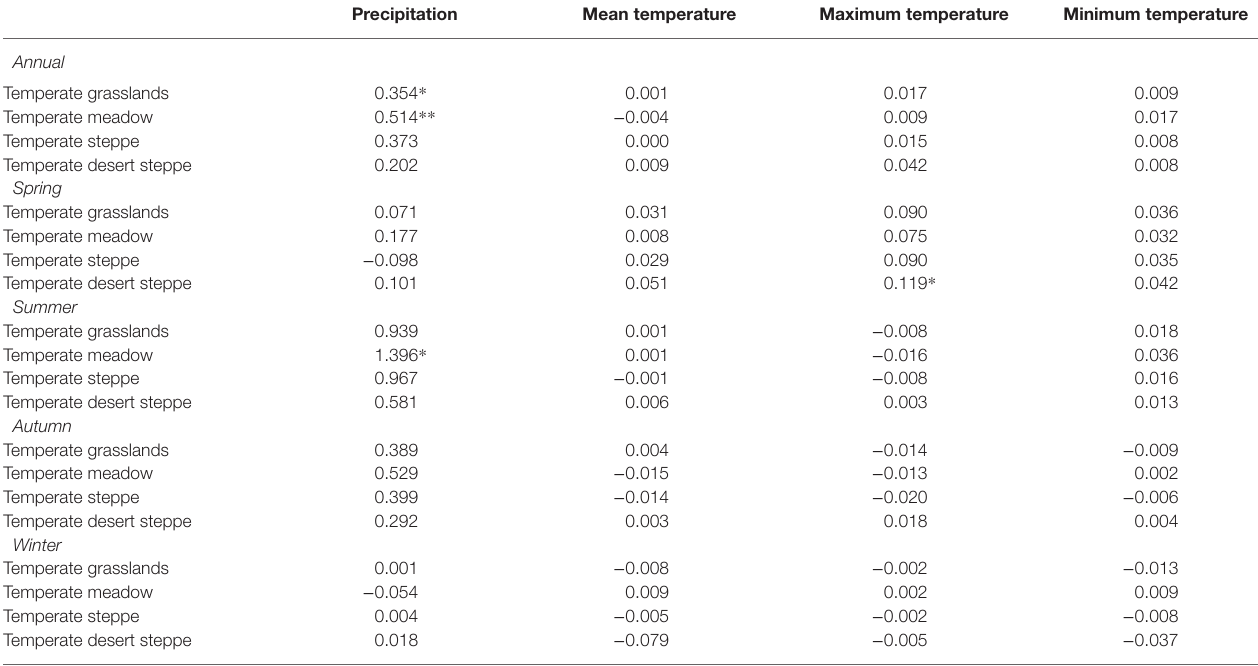
TABLE 3 | Temporal trends in temperatures ( ° C/year) and precipitation (mm/year) of temperate grasslands in China during